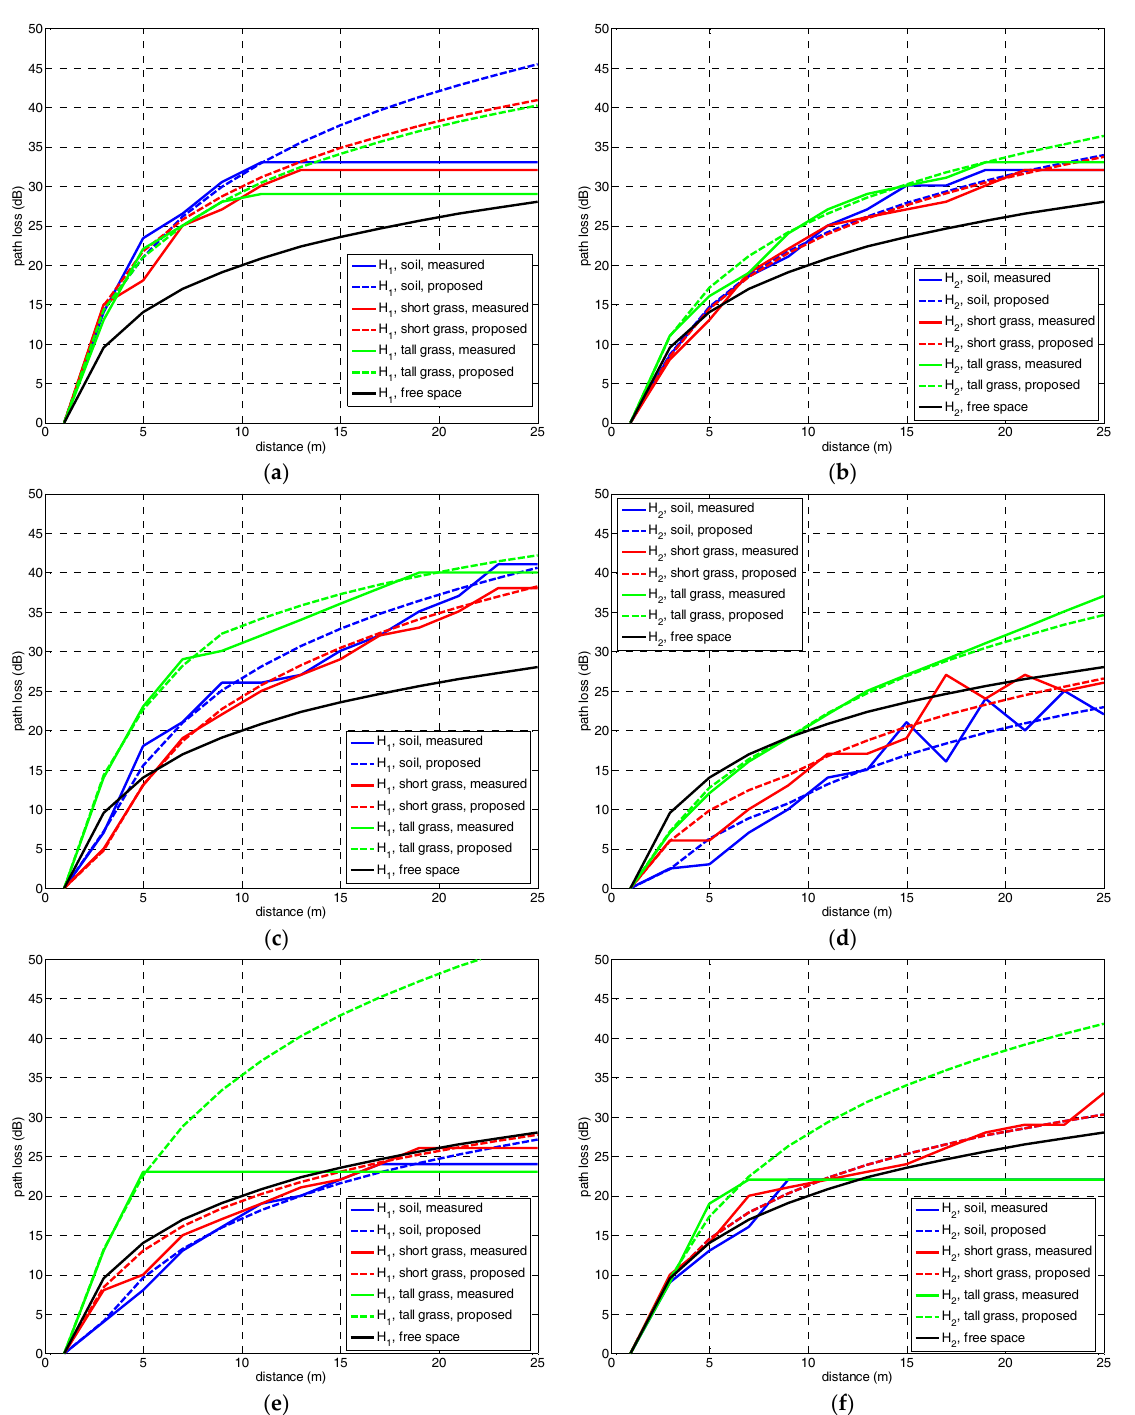
Figure 4. Path loss experimental results and comparison to free-space model and proposed model, at ( a ) F 1 , H 1 ; ( b ) F 1 , H 2 ; ( c ) F 2 , H 1 ; ( d ) F 2 , H 2 ; ( e ) F 3 , H 1 ; and ( f ) F 3 , H 2 Table 1. Obstruction of the First Fresnel Zone (FFZ) in percentage w.r.t antenna height. (cid:1832) (cid:1832) (cid:1832) (cid:2869) = 868 MHz (cid:2870) = 2.4 GHz (cid:2871) = 5.8 GHz (cid:1870) = √(cid:1856)(cid:2019) (m) 2.94 (cid:2869)